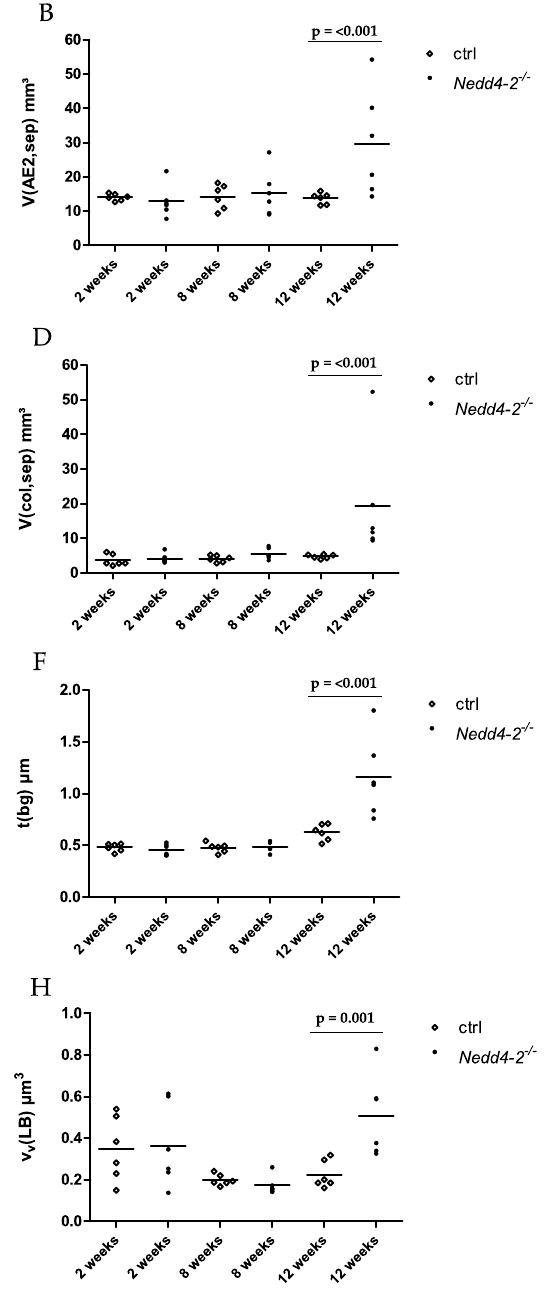
Figure 3. Septal microarchitecture of controls (ctrl) and Nedd4-2 -deficient ( Nedd4-2 −/− ) lungs. Stereological data determined at the electron microscopic level are provided in ( A – H ) and show total volume of AE1 cells within septal walls ( A ), total volume of AE2 cells within septal walls ( B ), total volume of interstitial cells (IC) within septal walls ( C ), total volume of collagen fibrils within septal walls ( D ), total volume of extracellular matrix without collagen fibrils within septal walls ( E ), arithmetic mean thickness of the blood–gas barrier, τ (bg) ( F ), total volume of lamellar bodies (LB) within septal walls ( G ) and volume-weighted mean volume of the lamellar bodies, ν V (LB) ( H ). Individual data and means are presented. The increase in the arithmetic mean thickness of the blood–gas barrier ( F ) after 12 weeks of Nedd4-2 deficiency is predominantly attributable to an increase of the volume of AE2 cells ( B ), the volume of interstitial cells ( C ) and the volume of collagen fibrils ( D ) by simultaneous decrease of the volume of AE1 cells ( A ). In addition, there is an increase of the volume of lamellar bodies ( G ) and the volume-weighted mean volume of the lamellar bodies ( H ) after 12 weeks of Nedd4-2 deficiency. Statistical analyses were based on a two-way ANOVA taking the factors genetics (G: ctrl vs. Nedd4-2 − / − ) and time (7: weeks) into account. Statistically significant differences after adjustment of the p -level for multiple testing using Tukey’s